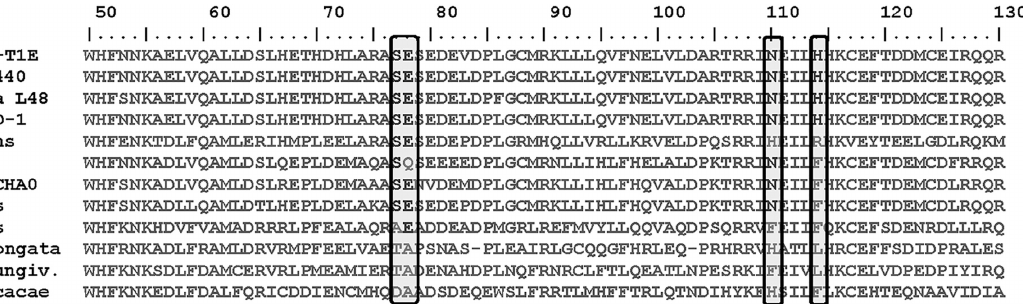
Fig 7. Sequence alignment of close homologues of TtgR ( Pseudomonas putida DOT-T1E). Mutated residues (S77, E78, N110 and H114) are boxed and shaded.